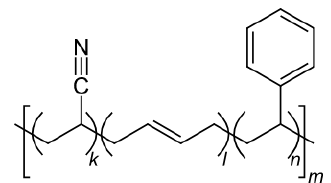
Figure 12. The chemical structure of ABS.